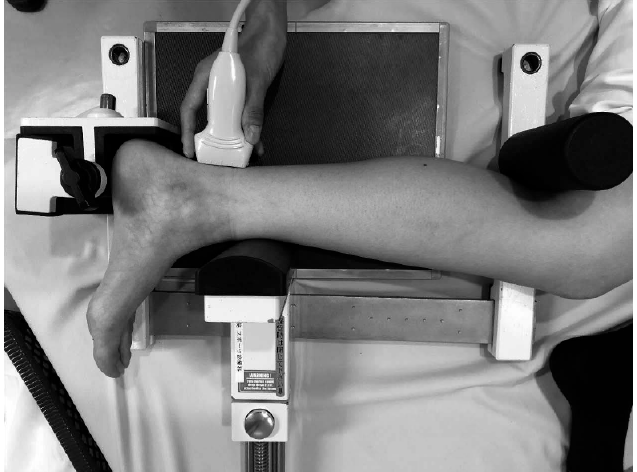
Figure 1. Positioning for the ultrasound stress imaging test and stress X-ray test. The probe was placed 5 mm inside from the center of the Achilles tendon on the posterior ankle along the direction of the major axis. (1) The popliteal fossa of the participant’s posterior knee rested tightly against the pole of the Telos device. (2) The knee joint was bent at 60° with the patella facing anteriorly. (3) The medial malleolus and lateral malleolus were aligned and kept perpendicular to the examination table. (4) The heel was pushed against the Telos device, and the angle of the ankle joint was 0°.